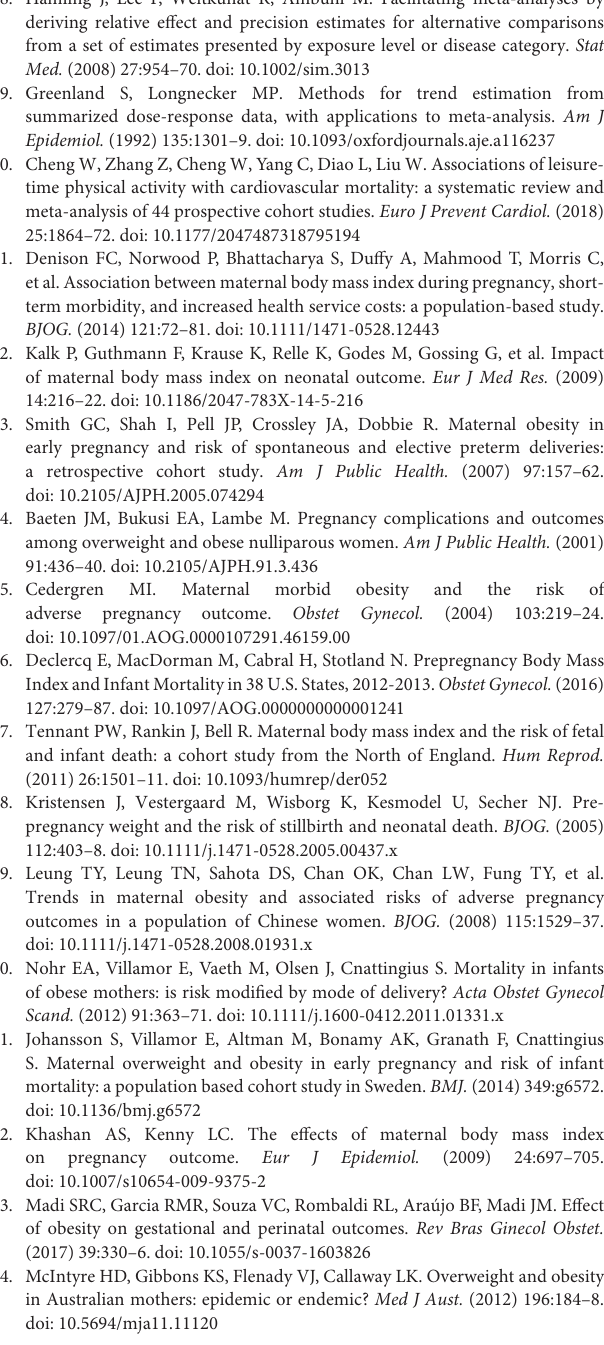
overweight and the risk of neonatal mortality. (C) The sensitivity analysis of maternal obesity and the risk of neonatal mortality. Supplementary Figure 4 | (A) The sensitivity analysis of maternal underweight and the risk of post-neonatal mortality. (B) The sensitivity analysis of maternal overweight and the risk of post-neonatal mortality. (C) The sensitivity analysis of maternal obesity and the risk of post-neonatal mortality. (D) The sensitivity analysis of maternal obesity and the risk of early neonatal